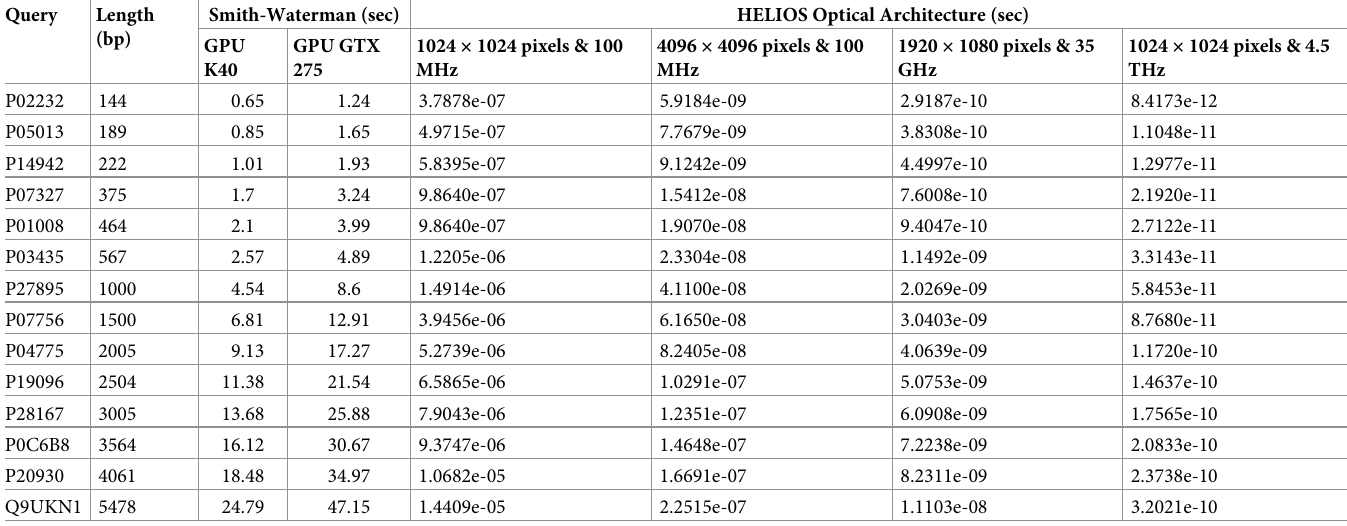
Table 20. Processing time of the HELIOS optical architecture, compared to Smith-waterman, assuming the SWISS-PROT database [64]. In this manner, various lengths of query sequences, from 144 to 5478 bases are aligned to the SWISS-PROT database [64], which contains 392,768 sequences and a total of 141,218,456 characters. In this regard, the processing times of Smith-waterman are reported by executing on NVIDIA TESLA K40 GPU with 44.3 giga cell updates per second (GCUPS) and GTX 275 with 21 GCUPS [65]. On the other hand, the processing times of HELIOS optical architecture are reported for a modulator with 1024 × 1024 pixels aperture size and 100 MHz switching rate [66] as a default, as well as for more recently developed modulators with various aperture sizes, such as 1920 × 1080 and 4096 × 4096 pixels, as well as various switching rates, including 35 GHz [72] and 4.5 THz